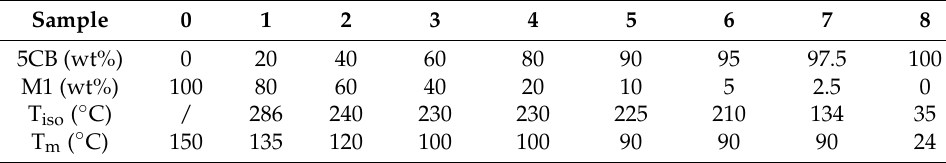
Table 1. Phase transition temperature of M1 and 5CB LC mixtures.